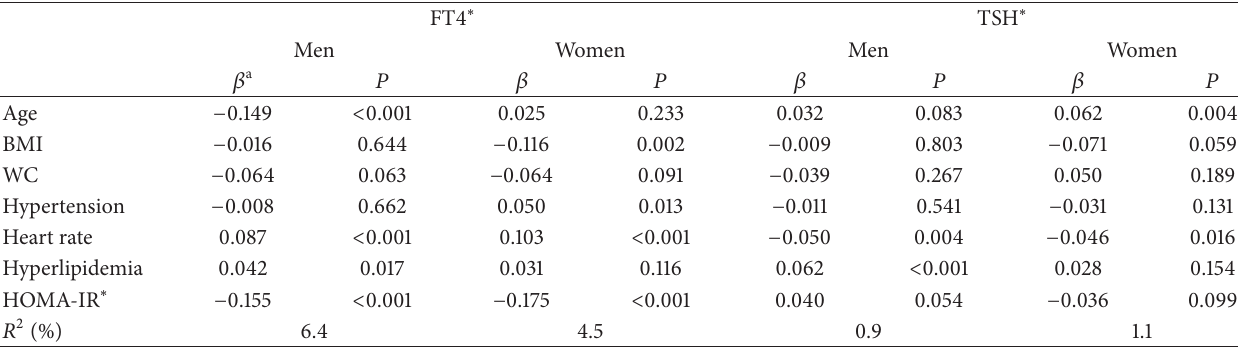
Table 3: Multiple regression analysis of determinants of serums FT4 and TSH concentrations.